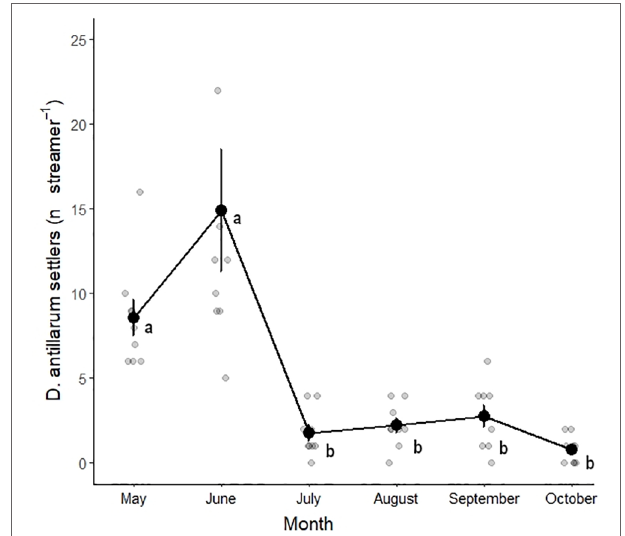
FIGURE 4 | D. antillarum settlers per streamer per month. The line connects averages (± SE) and gray points represent the replicate streamers. Averages sharing the same letter were not significantly different. A single result of 42 D. antillarum documented from a streamer in June falls outside the plotted y-axis limits but was used to calculate average (±